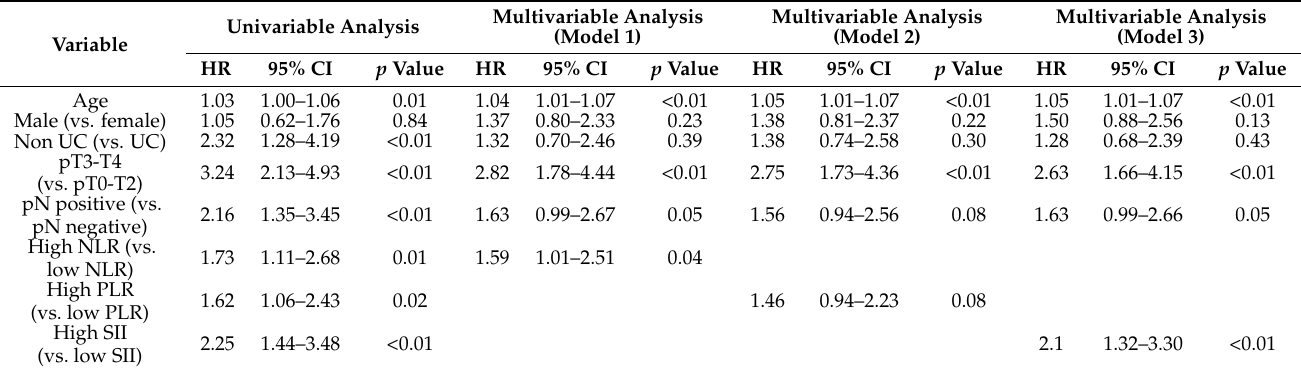
Table 4. Univariable and multivariable analyses of associations between various parameters and overall survival.